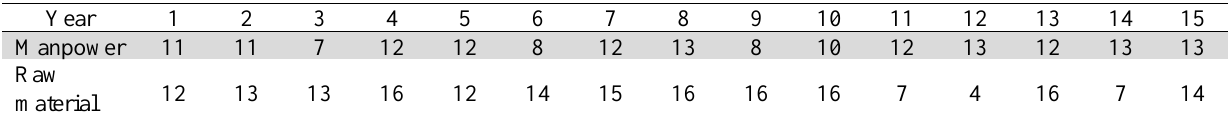
Amount of available resources Manpower Raw